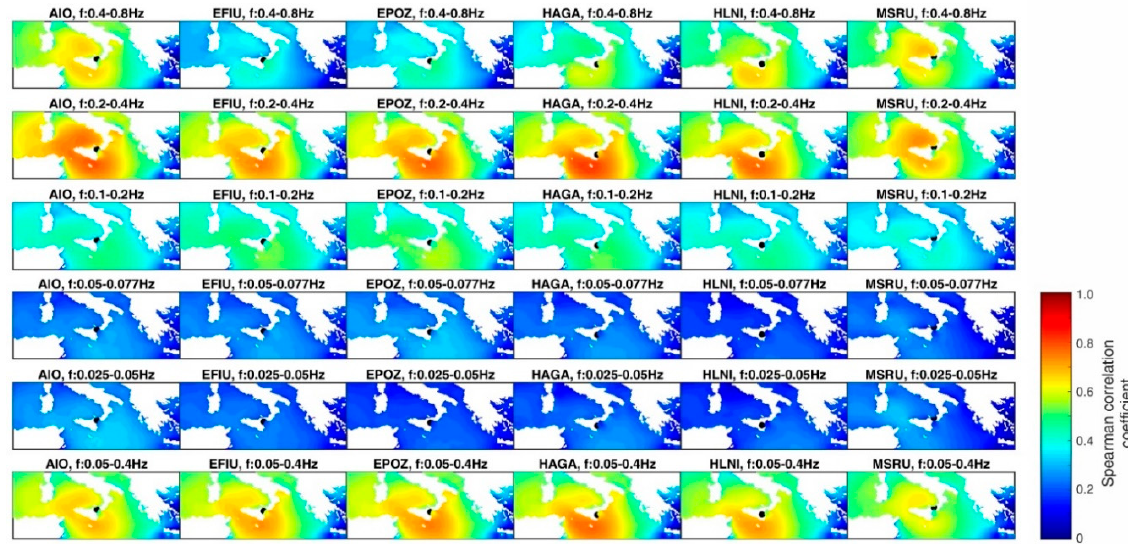
Figure 4. Maps of a portion of the Mediterranean Sea, showing the spatial distribution of Spearman’s correlation coefficient computed between significant sea wave height and seismic RMS amplitudes, calculated on the vertical component of the six considered stations and filtered in different frequency bands (see plot titles). The black dots indicate the locations of the considered stations.